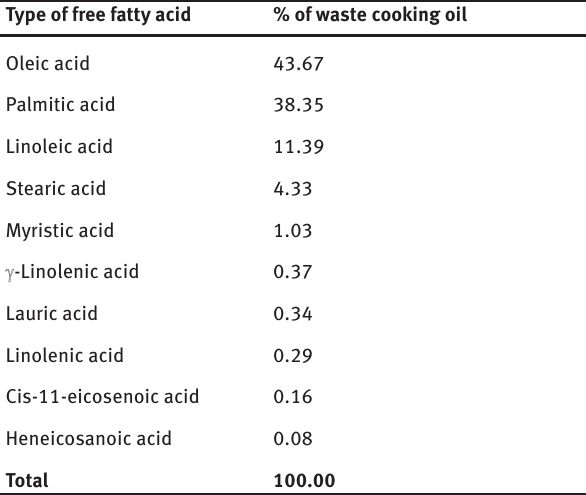
Table 2: Chemical properties of used cooking oil source [66]. Type of free fatty